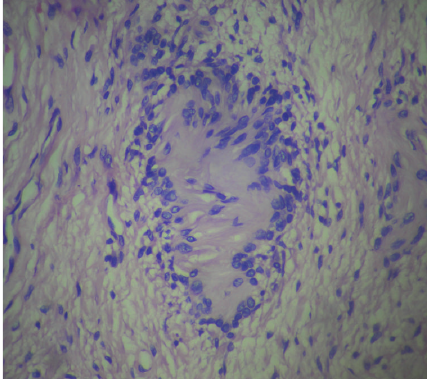
Figure 2: H&E, 400x; Verocay body in Antoni A areas.